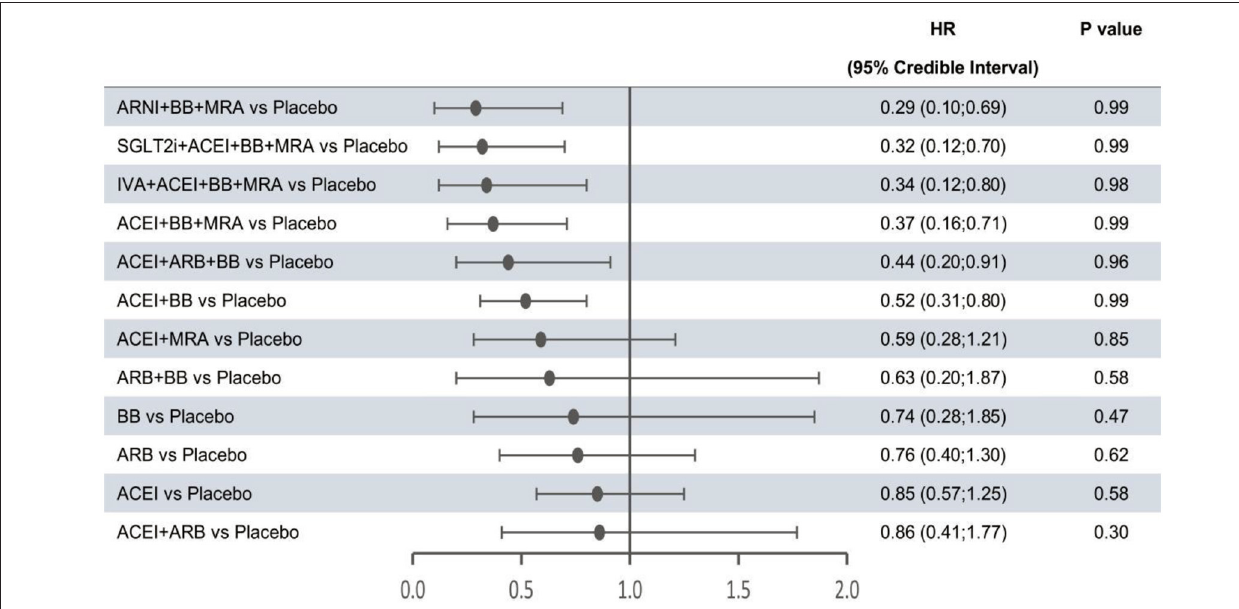
FIGURE 3 | Efficacy of interventions vs. placebo in cardiovascular mortality. Cardiovascular mortality was reported as hazard ratios (HRs) and 95% credible intervals for treatment vs. placebo. P -values were calculated based on the 95% credible intervals of hazard ratios and indicated the probability that the treatment was better